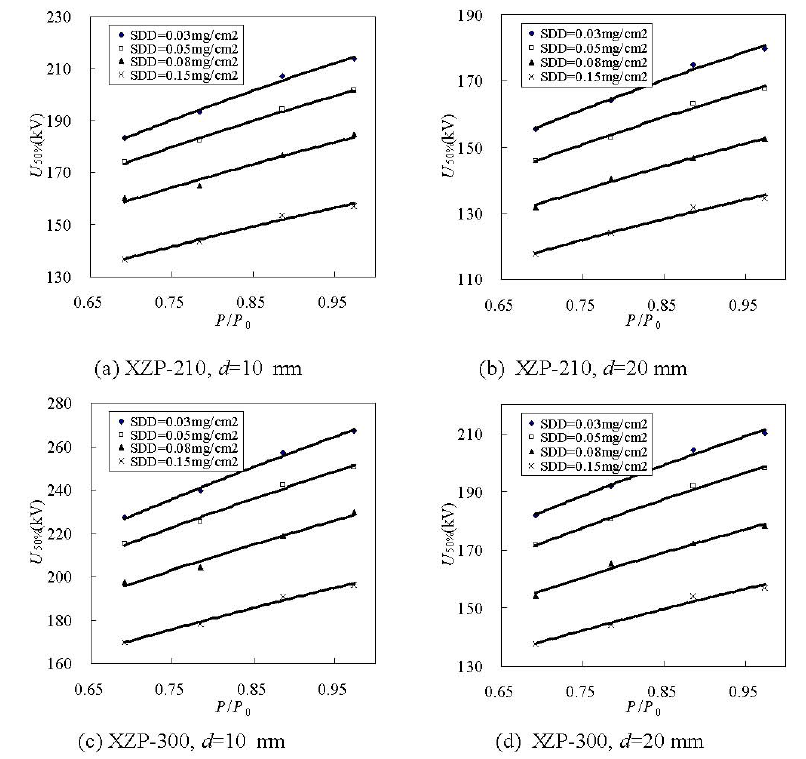
and P / P of insulator strings covered with 50% 0